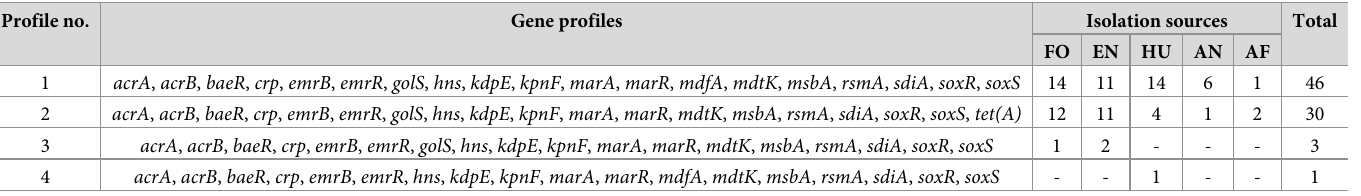
Table 2. Antimicrobial efflux pump encoding gene (ARG) profiles detected among the 80 Salmonella Infantis strains studied isolated from food (n = 27), farm and industry environments (n = 24), humans (n = 19), animals (n = 7) and animal feed (n = 3) in Brazil between 2013 and 2018. Profile